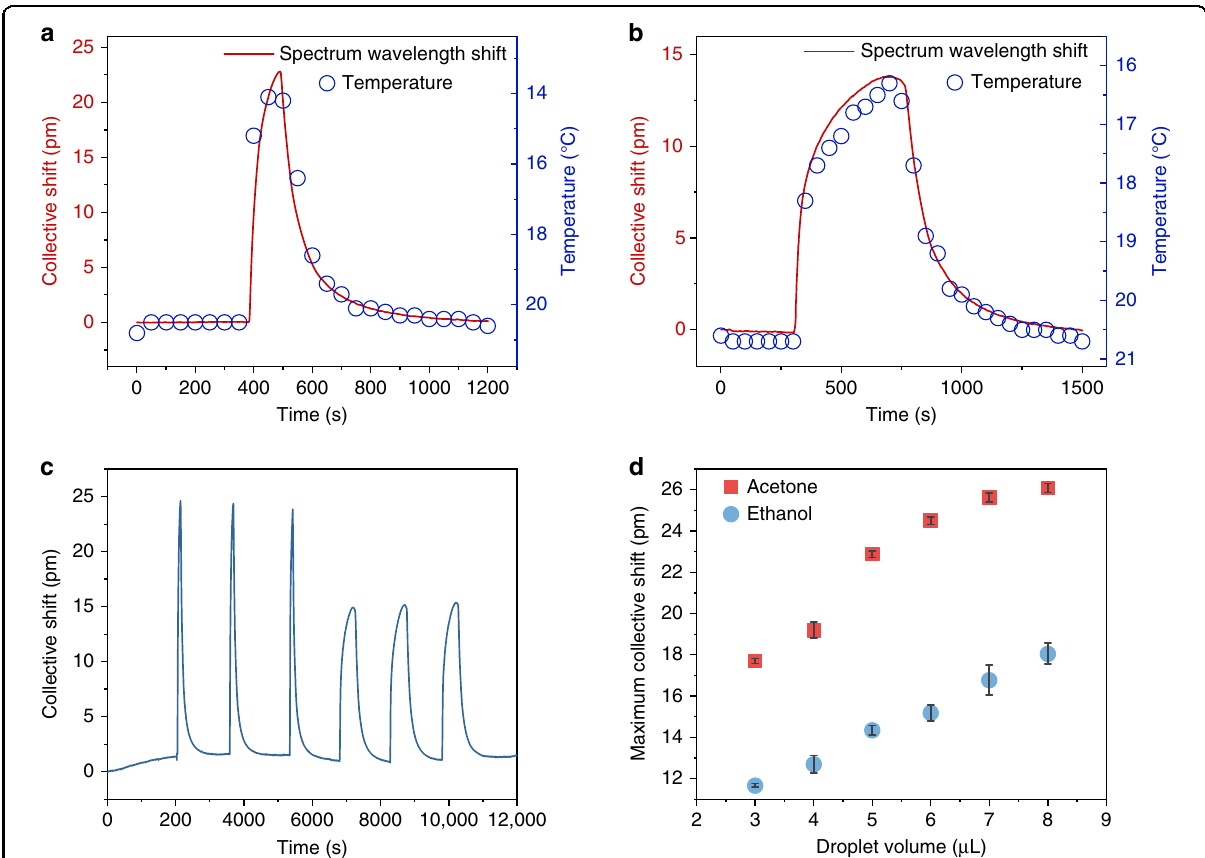
Fig. 4 Monitoring the spontaneous evaporation of liquid droplets. a Transient dynamics as an acetone droplet of 5 µL is positioned on the sensing surface. Red curve: collective shift of the spectrum. Blue circles: measured temperature. b Transient dynamics as an ethanol droplet of 5 µL is positioned on the sensing surface. Red curve: collective shift of the spectrum. Blue circles: measured temperature. c Sensorgram of droplet evaporation. The fi rst three peaks are the response for 5 µL acetone droplets, and the last three peaks are the response for 5 µL ethanol droplets. d Maximum collective shifts in response to the evaporation of acetone and ethanol droplets of various volumes (3 – 8 µL in 5 steps repeated 3 times). With a larger volume, the droplet would consume more heat from the surroundings and lead to a larger temperature change (maximum shift). For the same droplet volume, acetone causes a larger temperature change than ethanol during